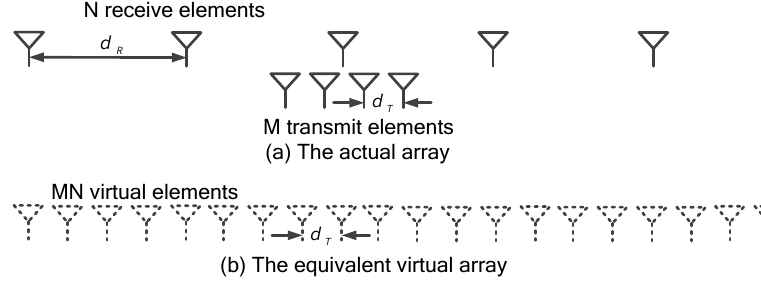
Figure 2. Sketch of the virtual array.